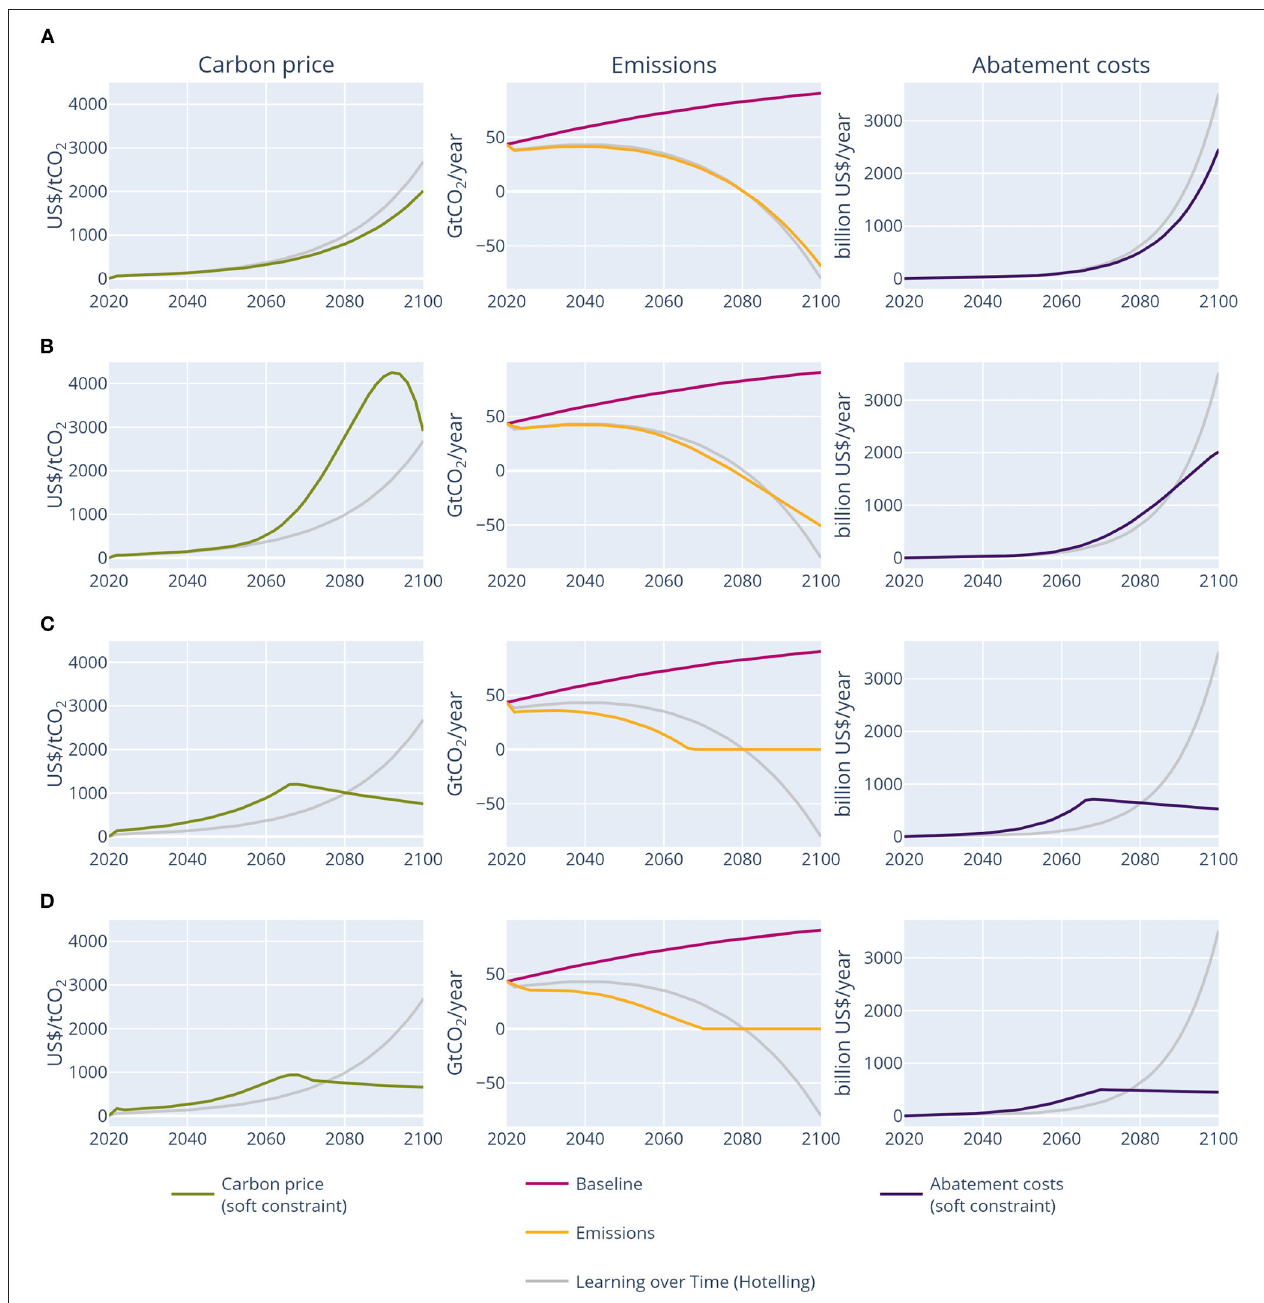
FIGURE 2 | Carbon price, emission, and abatement costs over time for different constraints and learning assumptions. (A) Learning by doing, (B) socio-economic inertia , (C) minimum emission level, and (D) combination.